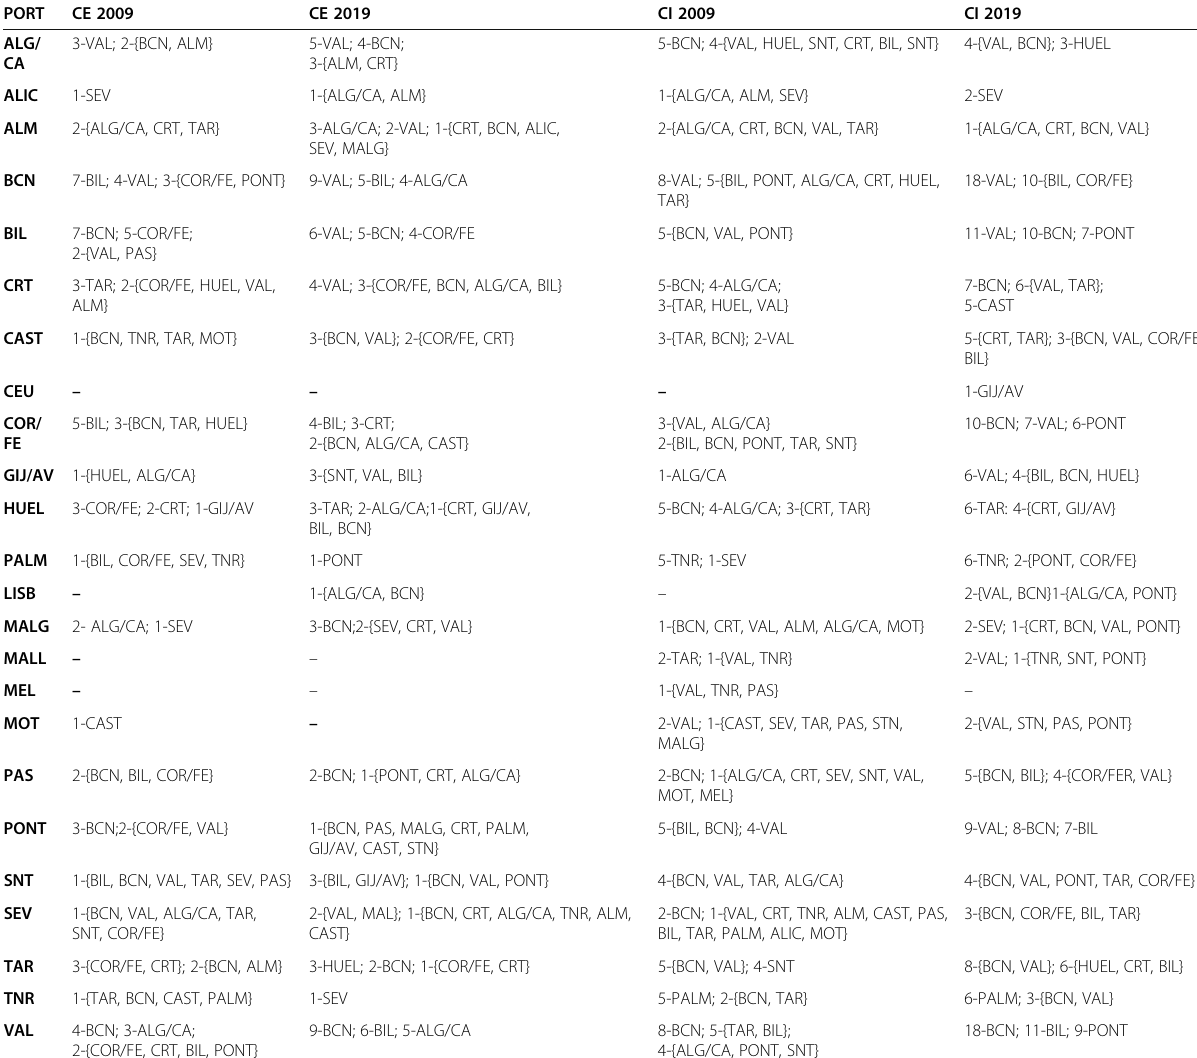
Table 8 For each port in the study, number of times that another port belongs to the same community, taking into account the 38 product categories. Ports are grouped into brackets when they share the same number of communities. Data for export (CE) and import (CI) flows in 2009 and